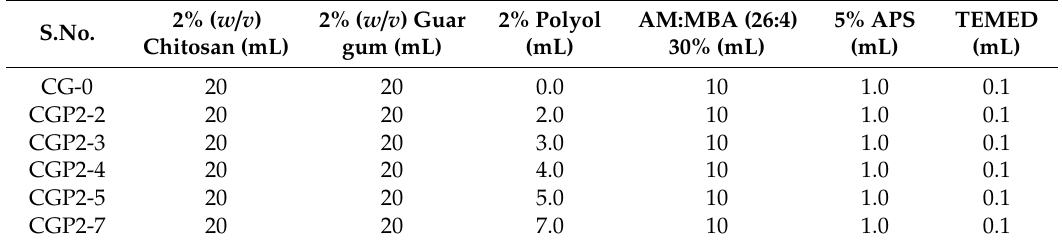
Table 1. Feed compositions of the hydrogel network of CH-GG / polyol.